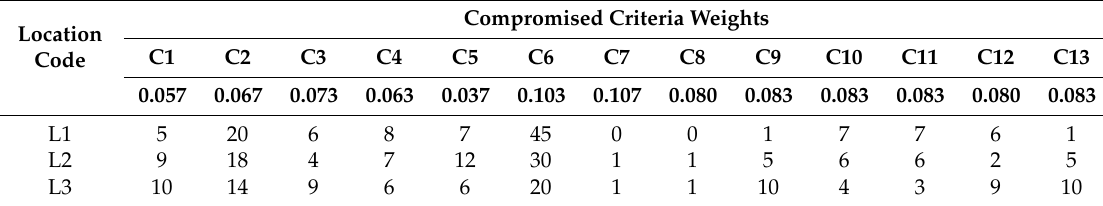
Table 3. Multicriteria